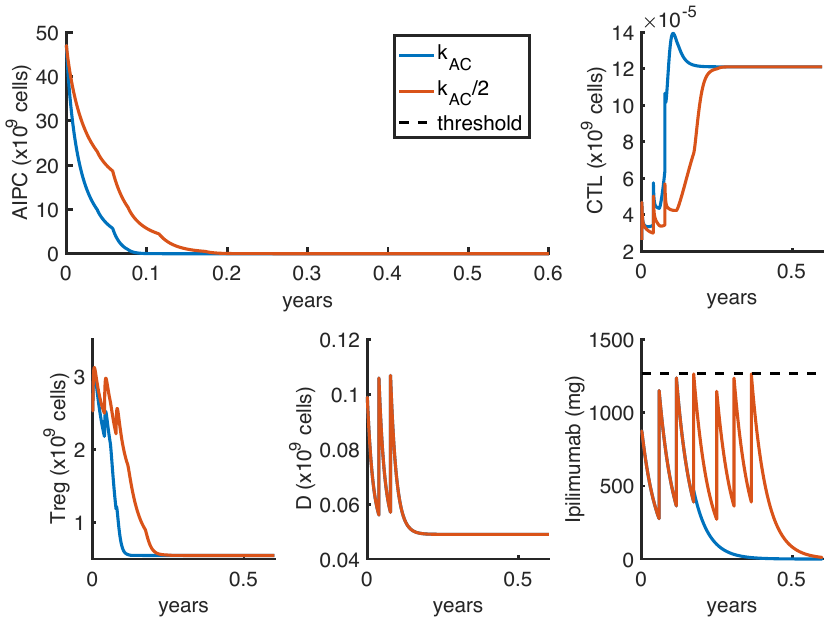
Figure A3. Comparison between administration protocols obtained with different values of the parameter k AC . The dynamics refer to the ipilimumab and sipuleucel-T combination therapy as result of the optimization problem OP2, with ∆ t = 3 weeks. Blue lines represent the model outcomes with the estimate value of k AC (the same presented in Figure 6, orange line), while orange lines represent the one with k AC . The ipilimumab threshold has been highlighted with a black dotted line. Table A4. Table of parameter estimates for the model.